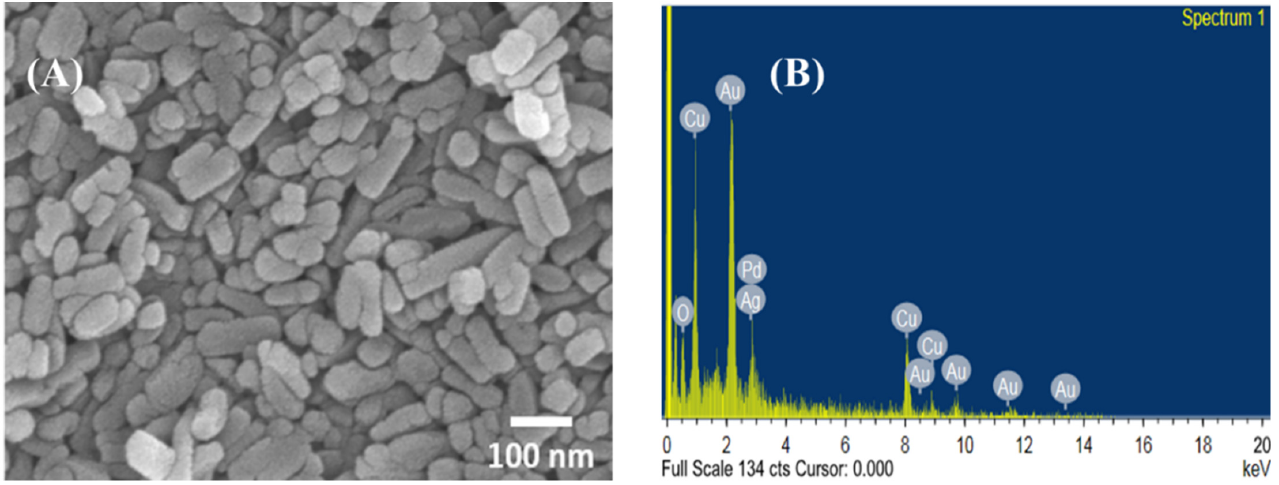
Figure 1. ( A ) SEM micrograph and ( B ) EDX spectrum of Ag-CuO NPs .